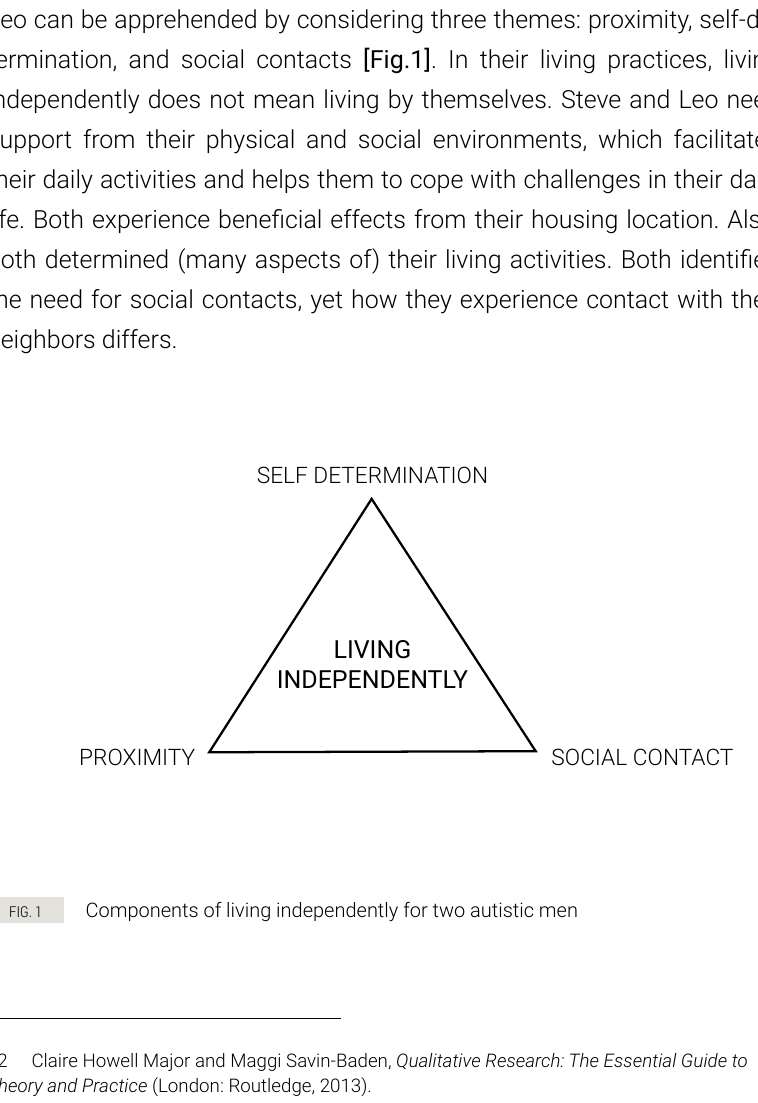
Components of living independently for two autistic men